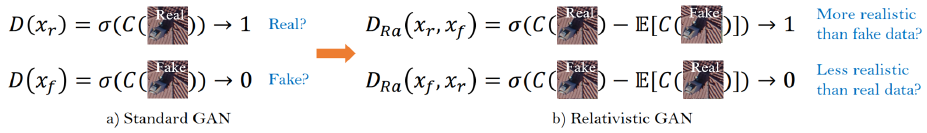
Figure 5. The standard and relativistic discriminators employed in the standard and relativistic GAN architectures, respectively